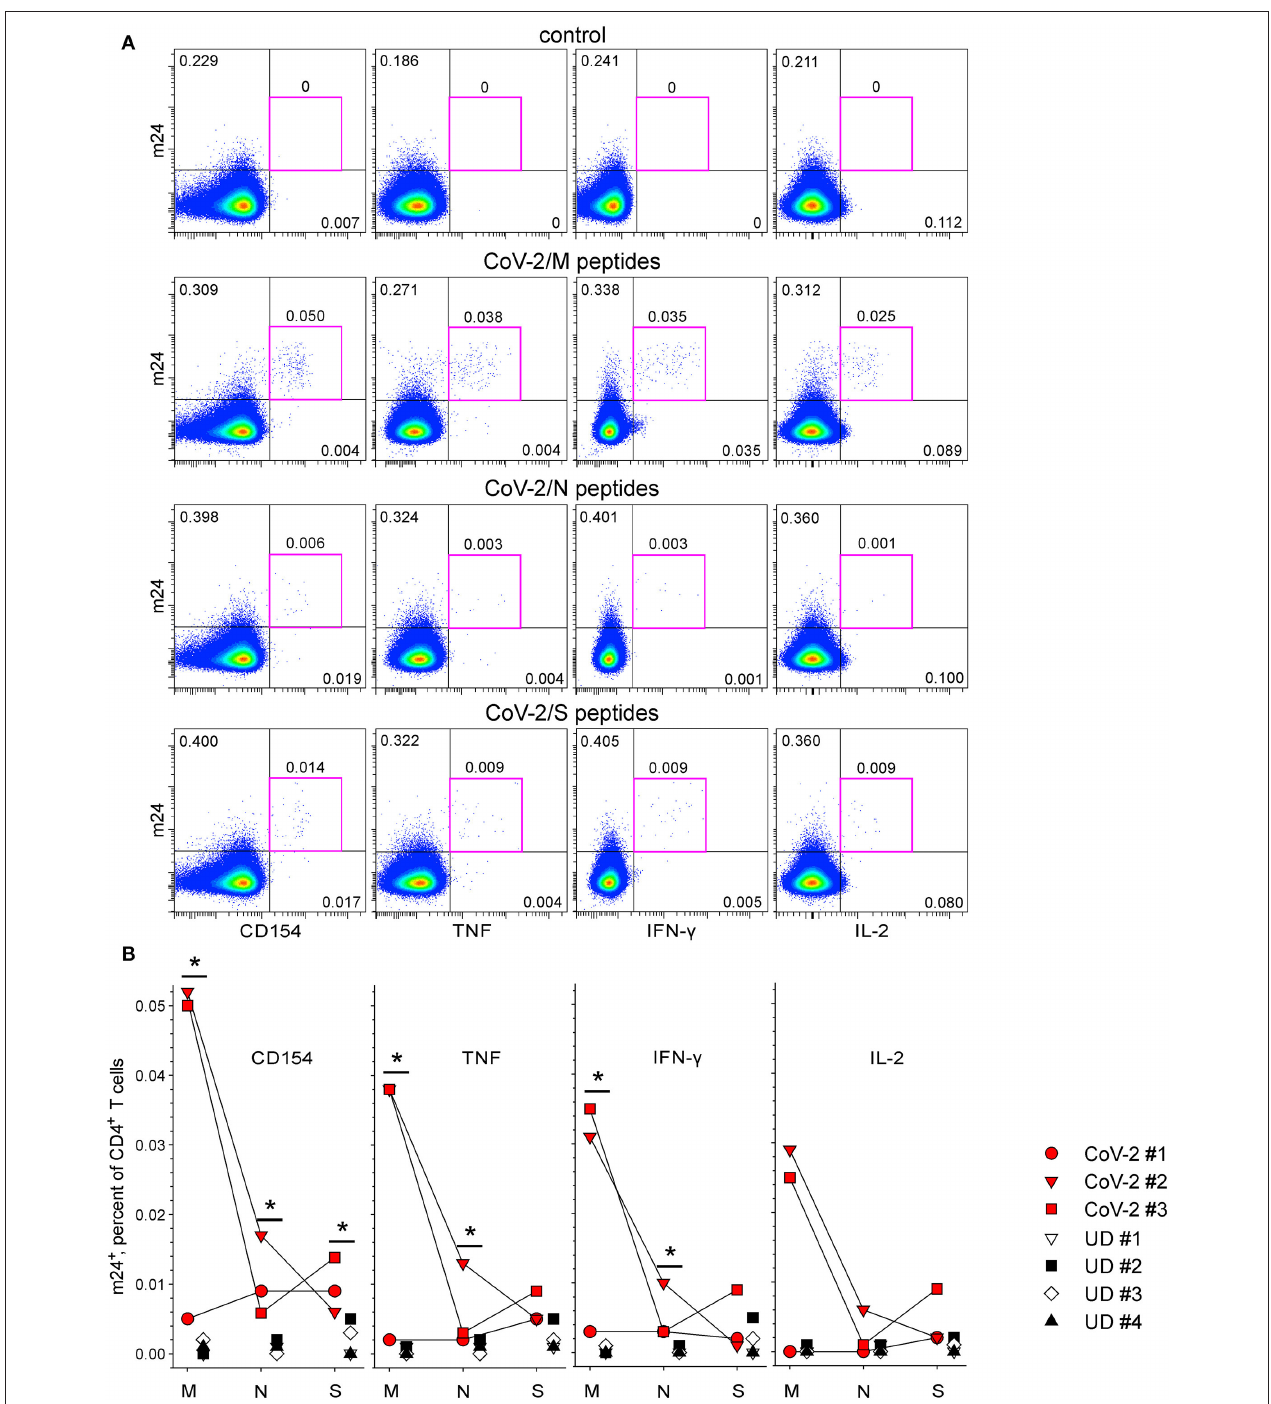
FIGURE 7 | The functional profile of severe acute respiratory syndrome coronavirus 2 (SARS-CoV-2)-specific m24 + CD4 + WB T cells. m24 Ab staining in combination with CD154, TNF, IFN- γ , or IL-2 expression after stimulation with pools of CoV-2 membrane (M)-, nucleocapsid (N)-, and spike (S)-derived overlapping peptides for 4h. (A) Examples of m24 Ab staining obtained from CoV-2 #3 without stimulation (control) or in the presence of the M, N, or S peptides. Numbers indicate frequencies among CD4 + T cells in %. (B) The results for marker + m24 + CD4 + T cells obtained from SARS-CoV-2 convalescents ( n = 3, CoV-2 #1 to #3) and unexposed healthy controls ( n = 4, UD #1 to #4) are shown as graphs (after subtraction of background assessed in the control test). Asymptotic significance was calculated using two-tailed Mann–Whitney U -tests, * p < 0.05. Numbers indicate frequencies among CD4 + T cells in %. Gating strategy is as shown in Figure 1A .